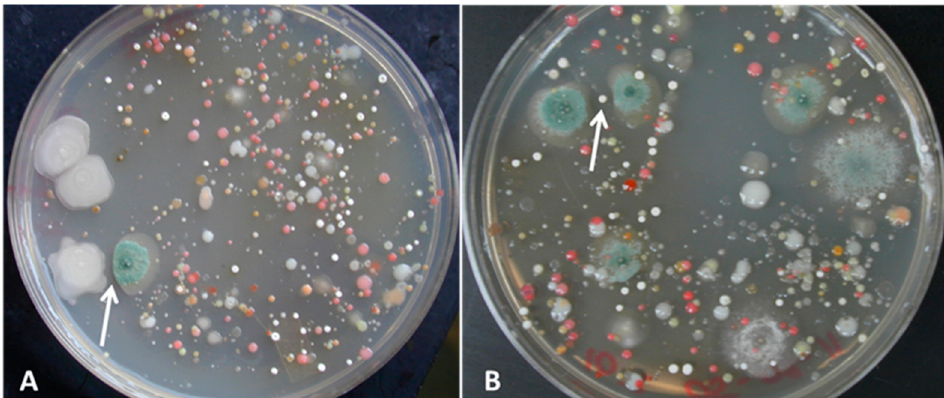
Figure 2. Visible zone of inhibition between bacterial colonies and fungal colonies (samples from site 1 [CLR]). ( A ) A large bacterial colony related to Bacillus sp. is inhibiting the growth of a Penicillium sp. Small white colonies were identified as members of the Streptomyces genus which indicates that these bacteria are among the dominant members of the cultivable soil microbiota at our sampling sites. Results for site 2 were similar (not shown). ( B ) A small bacterial colony identified as Streptomyces sp. is inhibiting a Penicillium sp. The zones of inhibition are indicated by a white arrow.